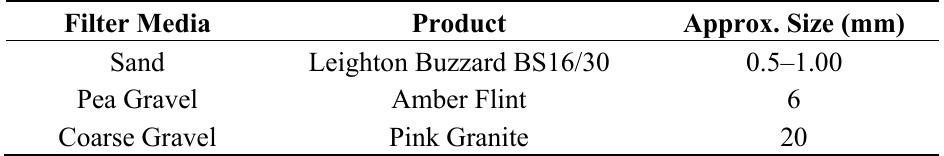
Figure 3. From Left to Right—Granular Filter Rigs Nos. 1, 2 and 3 with varying layers of gravel, pea gravel, sand and geotextile membrane. Table 1. Aggregates and filter media used in the granular filtration